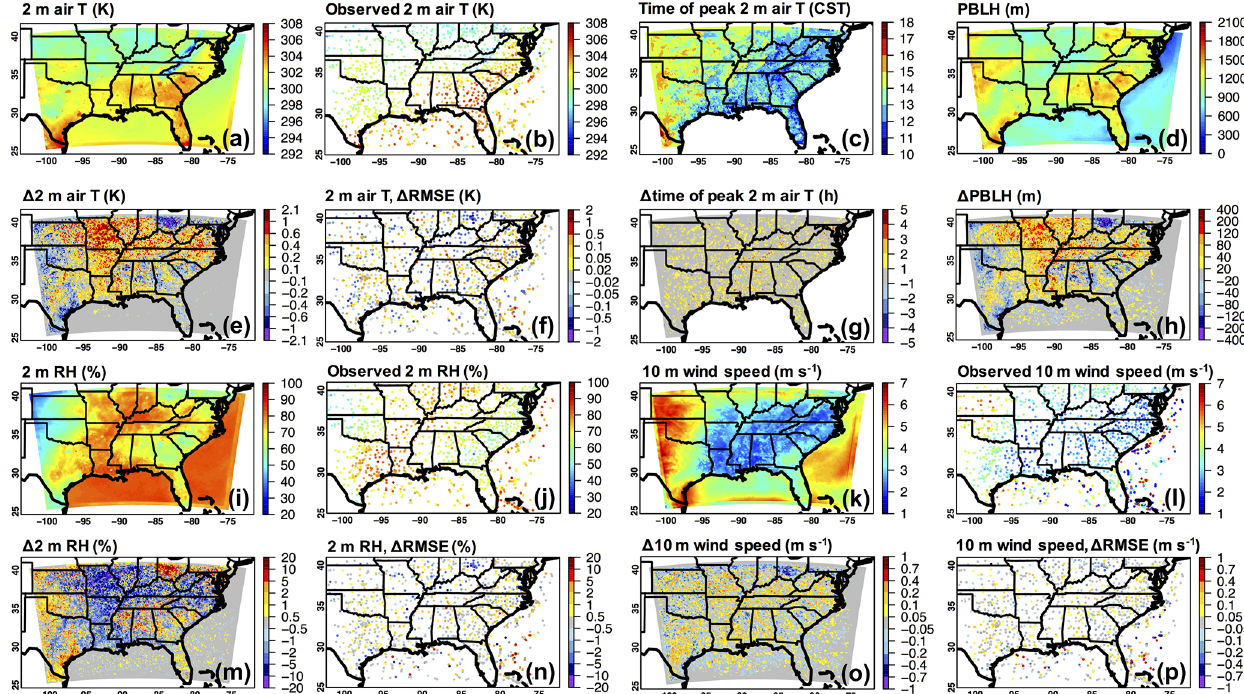
Figure 3. Period-mean (16–28 August 2016) WRF-Chem base case daytime (a) 2m air temperature ( T ); (d) PBLH; (i) 2m relative humidity (RH); and (k) 10m wind speed, as well as (e, h, m, o) the impacts of SMAP DA on these model fields. Observed daytime surface T , RH, and wind speed, as well as the impacts of the SMAP DA on RMSEs of these model fields are shown in (b, f) , (j, n) , and (l, p) respectively. Significance test results are included in Fig. 4. The time of daily peak air T in US central standard time (CST), as well as its response to the SMAP DA, is shown in (c, g)